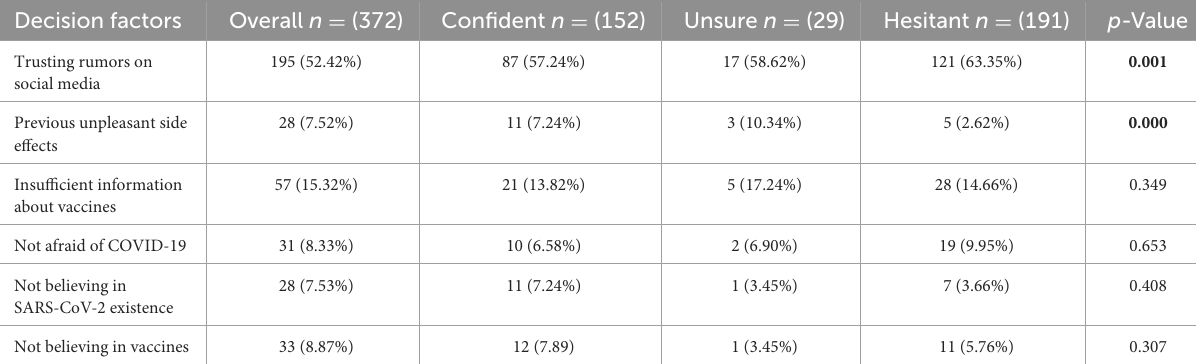
TABLE 3 Assessment of pregnant study participants based on decision